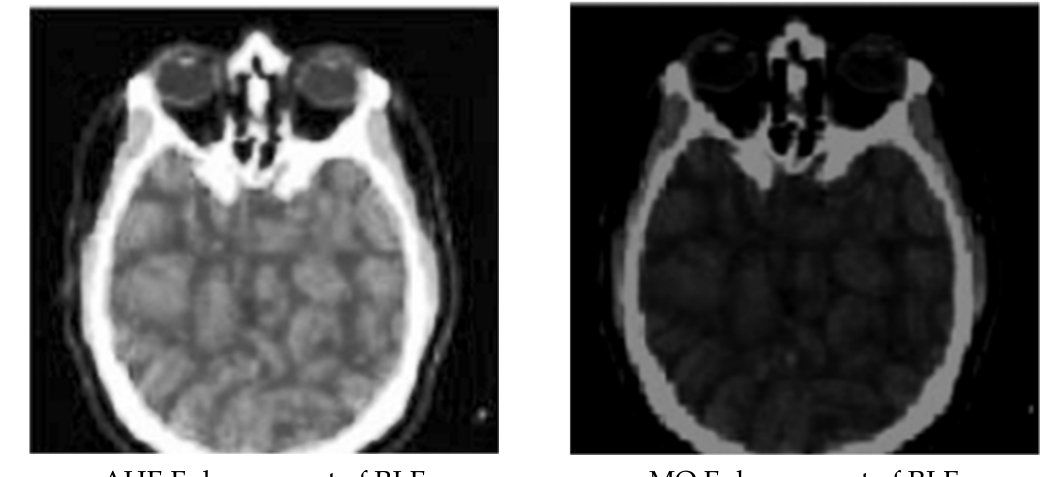
Figure 5. Lossless techniques: Enhancement of RLE using AHE and MO.